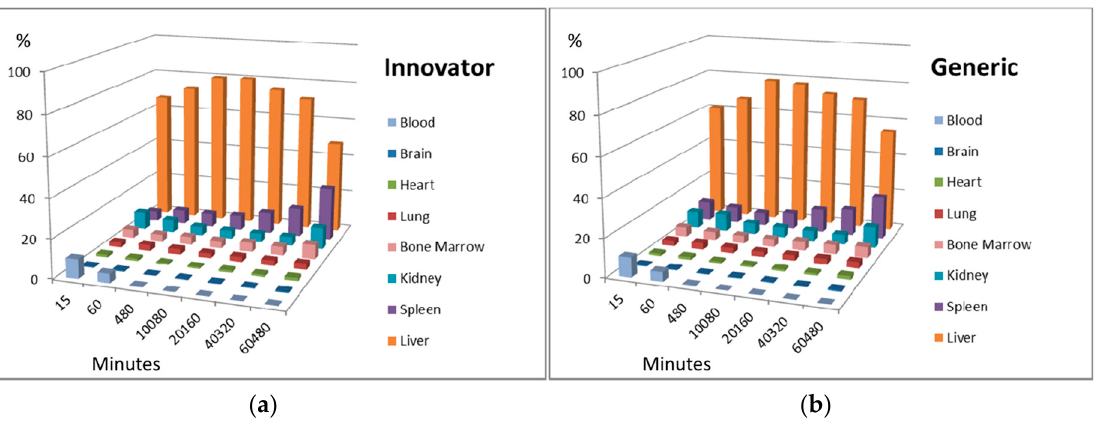
Figure 9. Percent distribution of the innovator and genetic drug iron concentration among the analyzed organs; ( a ) innovator drug; ( b ) generic drug; n = 6 per group per time point. organs; ( a ) innovator drug; ( b ) generic drug; n = 6 per group per time